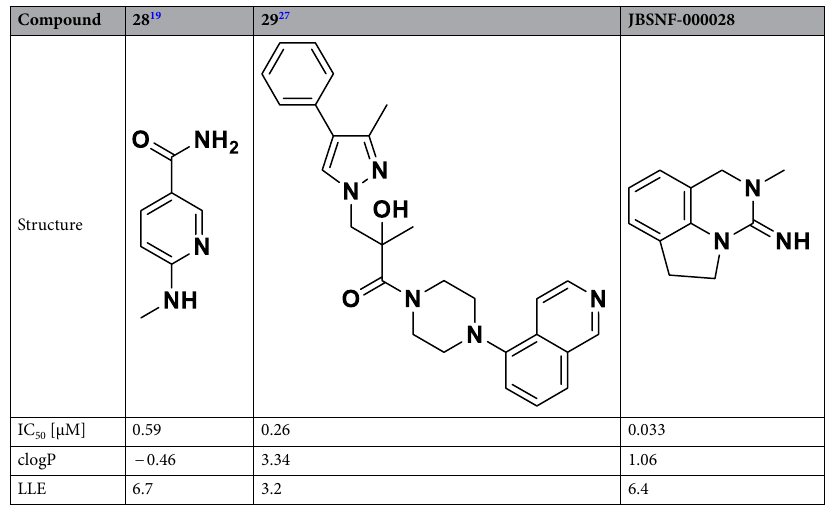
Table 7. Lipophilic Ligand Efficiencies (LLE) of published NNMT inhibitors compared to